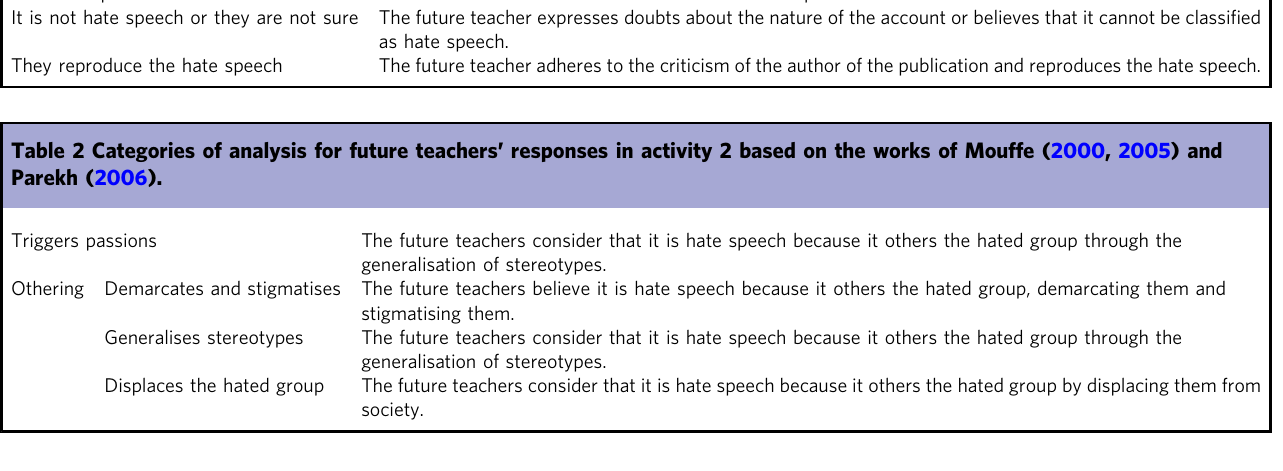
Table 1 Categories of analysis for future teachers ’ responses in activity 1. It is hate speech